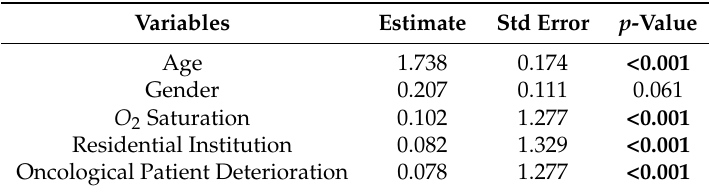
Table 2. Coefficients, standard error, and p -values for the significance of the variables in the logistic regression. Those variables with p < 0.05 are highlighted in bold.